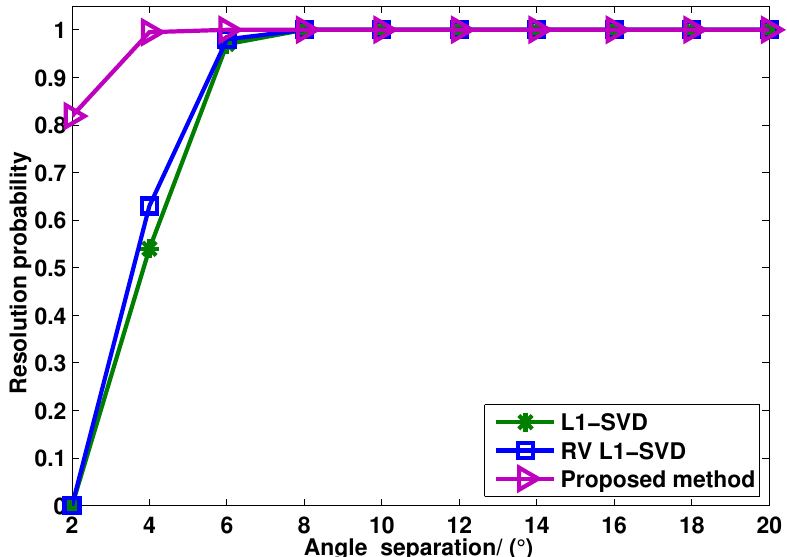
Figure 4. Target resolution probability of l two uncorrelated targets when the angle separation varies from 2 ◦ to 20 ◦